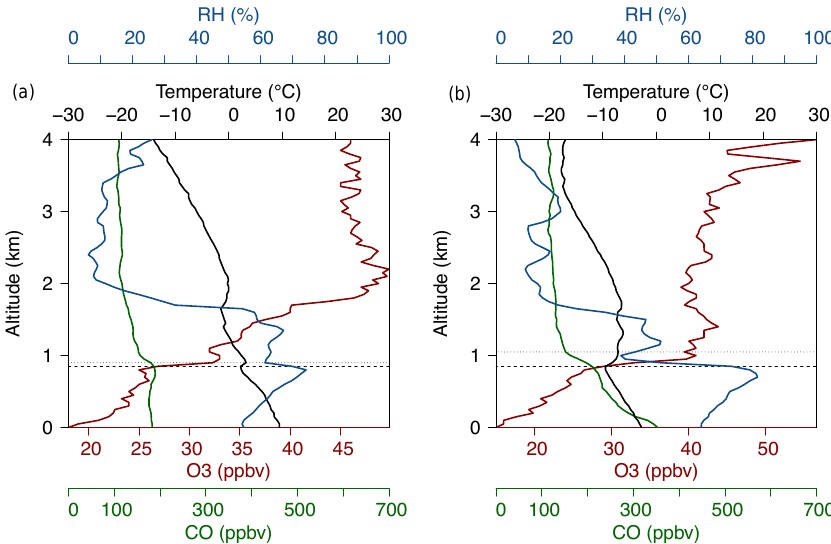
Figure 2. Vertical profiles measured by IAGOS on 2004/11/28 (flight no. 10275975, a ) and 2004/12/22 (flight no. 10451135, b ). The curves display the profiles of O 3 (red line) and CO (green line) mixing ratios, RH (blue line) and temperature (black line). The plot also shows the base (dashed black line) and top (dotted black line) of the elevated temperature inversion. sbi0 ANN ( IAGOS+SONDES )